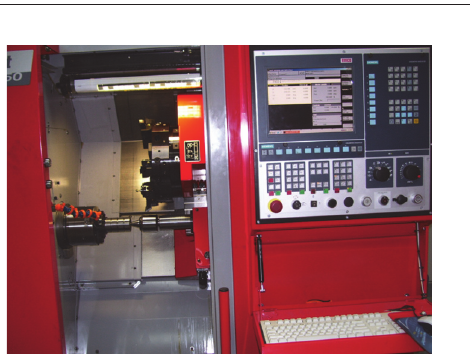
Figure 2: Test rig for samples machining.